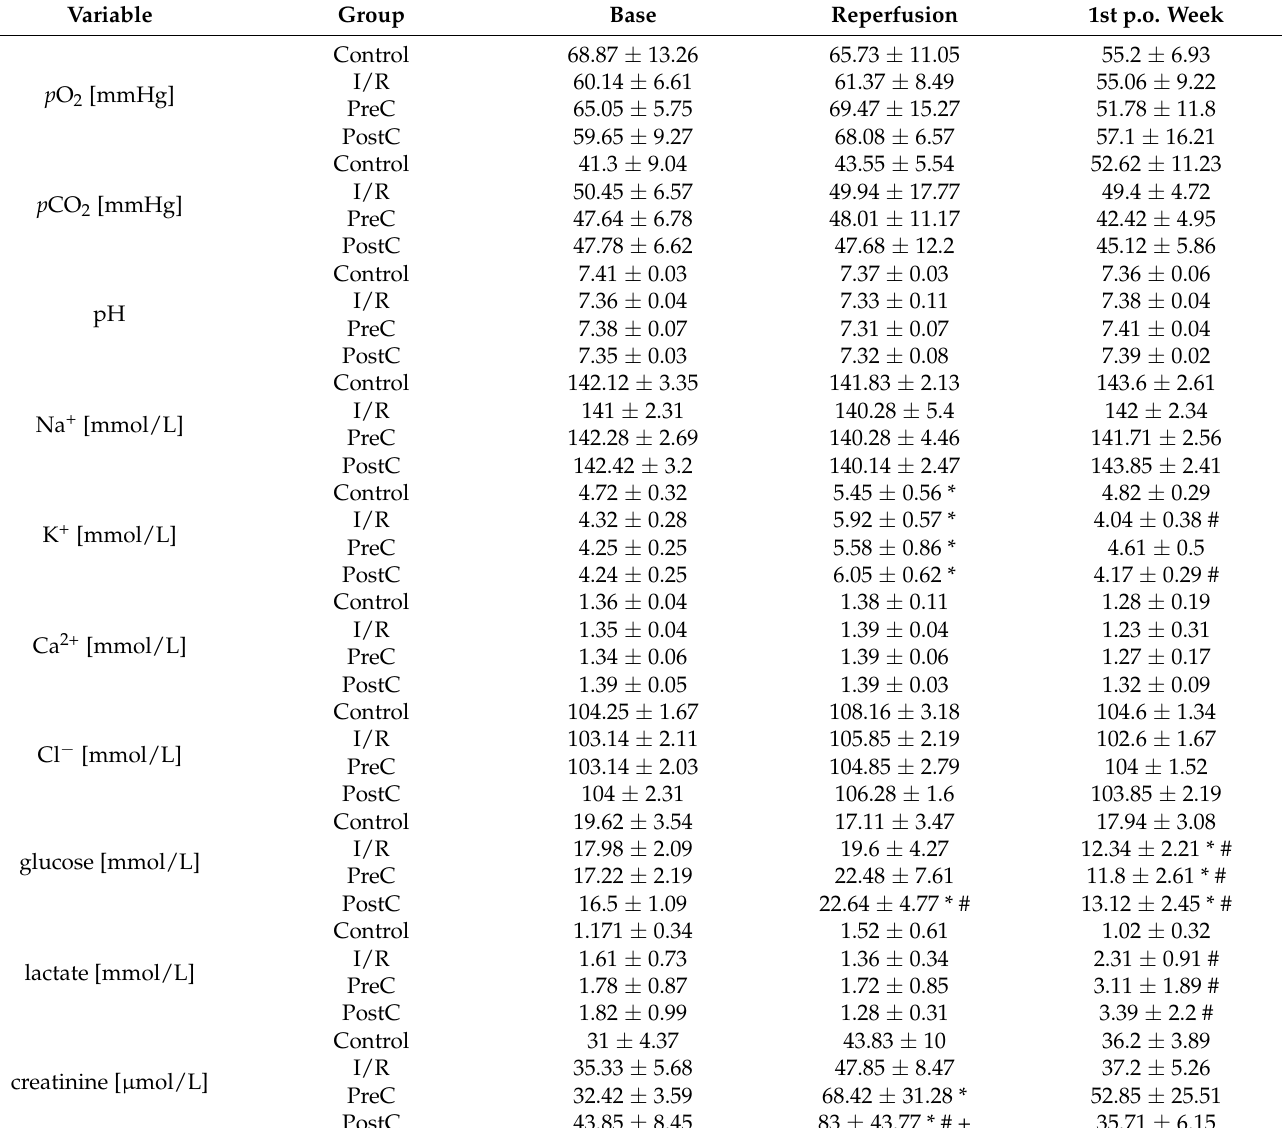
Table 3 summarizes the changes of blood gas, pH, electrolyte, and metabolic parameters. Table 3. Changes of blood gas ( p O 2 , p CO 2 ), pH, electrolytes (Na + , K + , Ca 2+ , Cl − ,) and metabolites (glucose, lactate, creatinine) in the control, the ischemia-reperfusion (I/R), the ischemic pre-conditioning (PreC), and the ischemic post- conditioning (PostC)